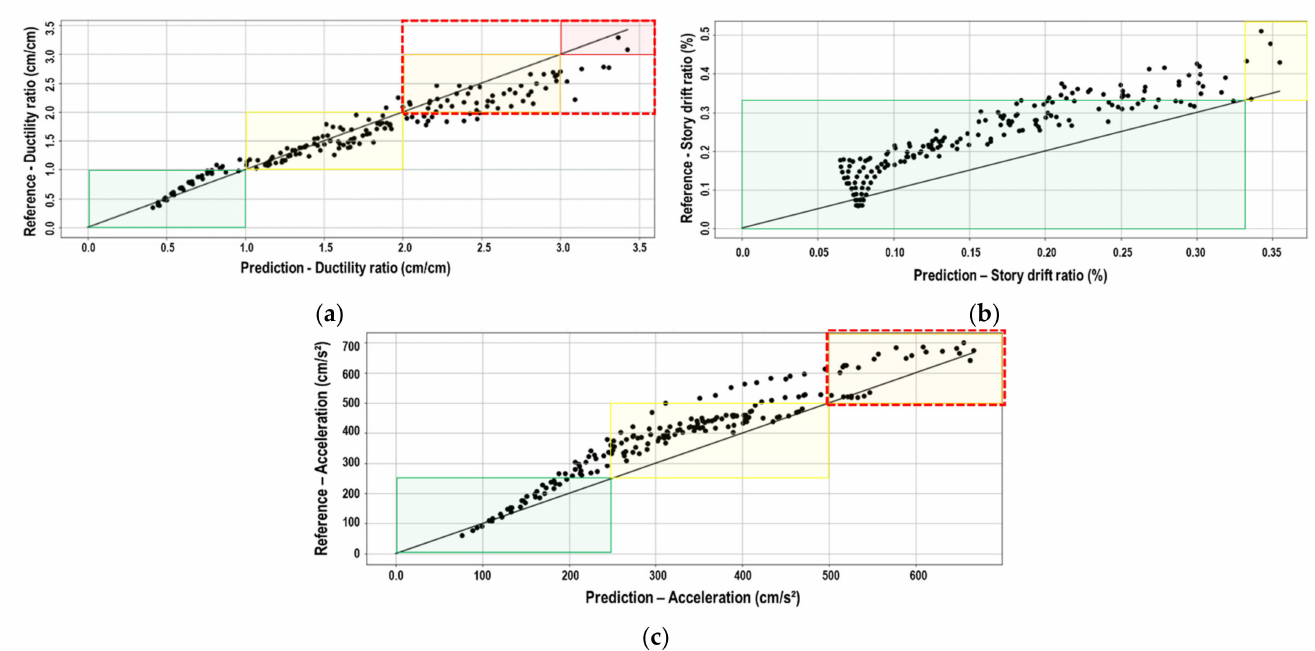
Figure 21. Comparison between reference and prediction of the Petrolia California N–S record for the validation process of ( a ) Ductility ratio; ( b ) Story drift ratio, and ( c ) Acceleration.